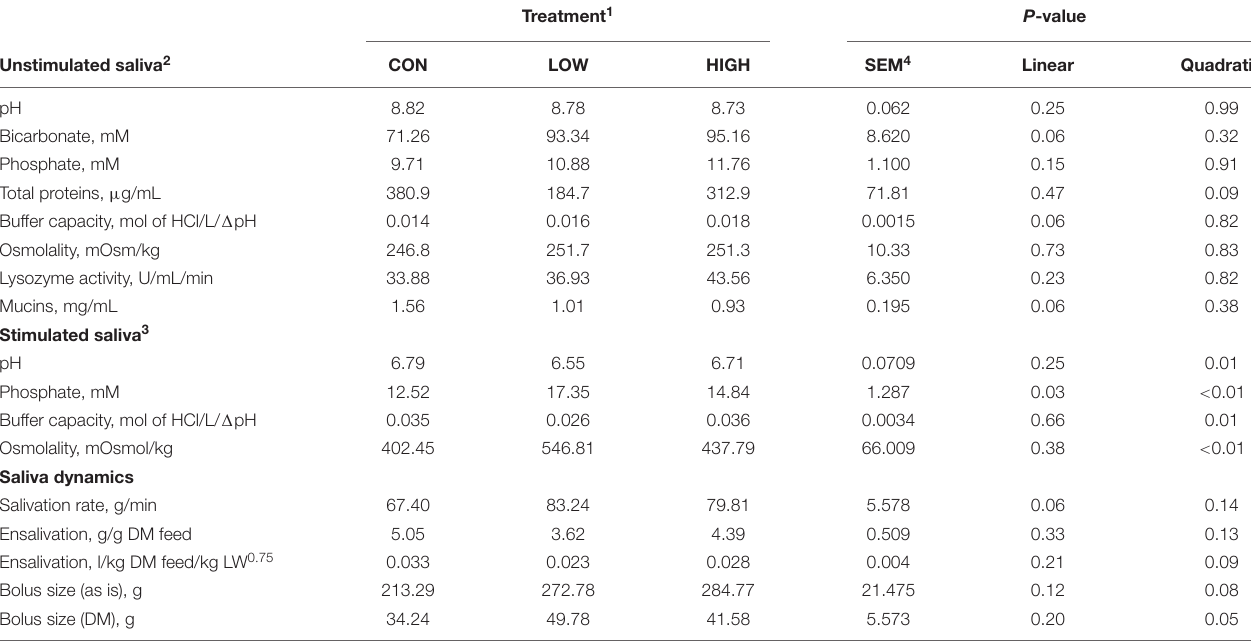
TABLE 1 | Effect of supplementation with garlic oil on salivary physico-chemical properties, salivation, and feed bolus dynamics of non-lactating Holstein dairy cows. Treatment 1